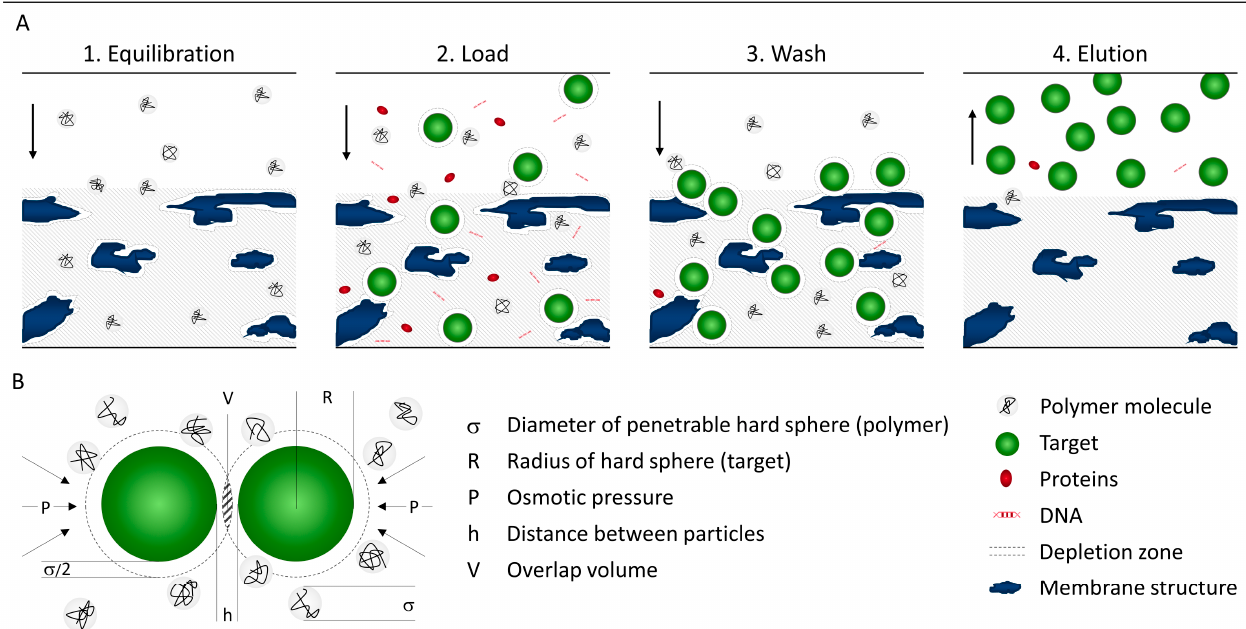
Figure 2. Principles of SXC. ( A ) Steps of SXC: equilibration of stationary phase with PEG-containing buffer. Next, the feed solution mixed with PEG buffer is loaded and the association of the target with the stationary phase occurs. A wash step with a PEG-containing buffer follows to wash out the remaining impurities before final elution without PEG. ( B ) Depletion interaction between two hard spheres in the presence of PEG. Arrows indicate flow direction. Figure adapted from [16,17].